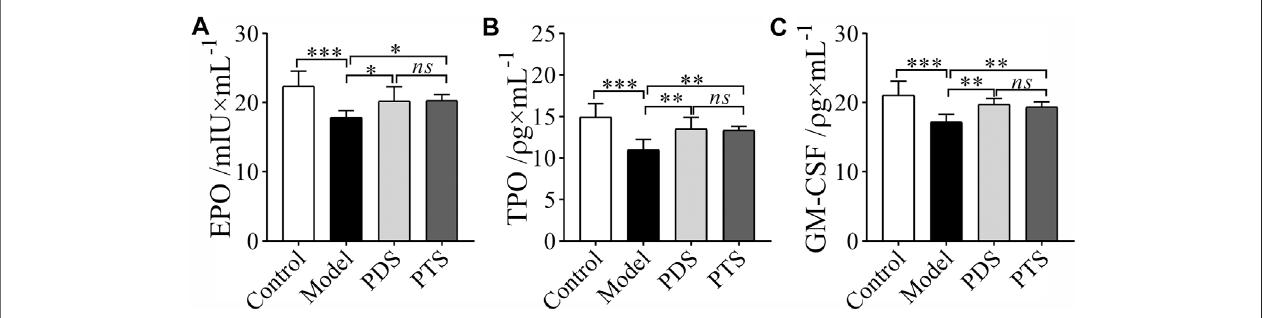
FIGURE 5 | The effects of PDS and PTS on hematopoiesis-related cytokines in myelosuppression mice. (A) Erythropoietin (EPO); (B) Thrombopoietin (TPO); (C) Granulocyte-macrophage colony stimulating factor (GM-CSF). The data are expressed as mean ± SD ( n = 5), * p < 0.05, ** p < 0.01 and *** p < 0.001 compared with the model group; ns showed no signi fi cance between the two